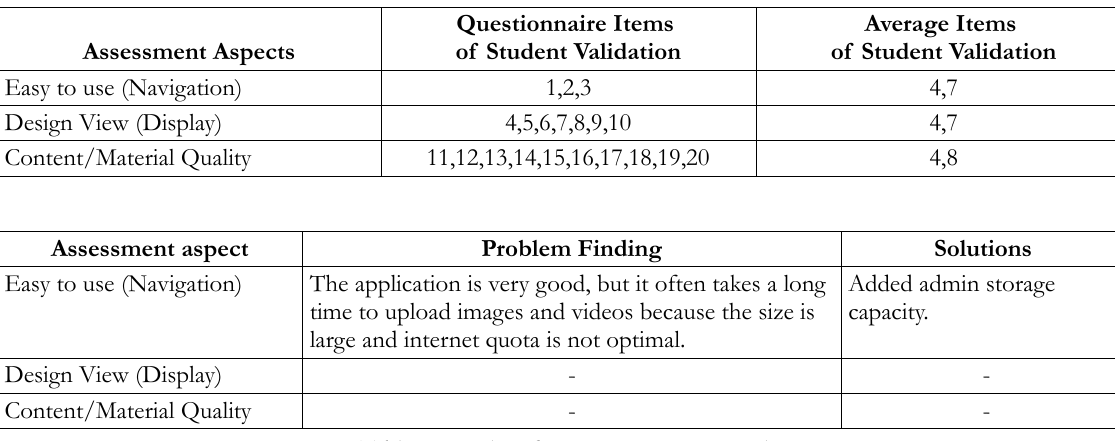
Table 6. Results of one to one try-out trial